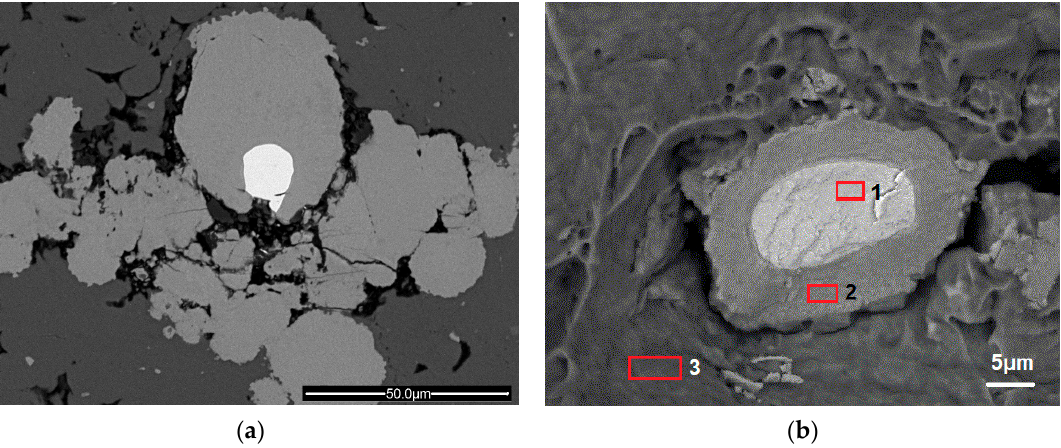
Figure 19. SEM images of SHS717-Al TBC: ( a ) microstructure; ( b ) fracture surface topography.